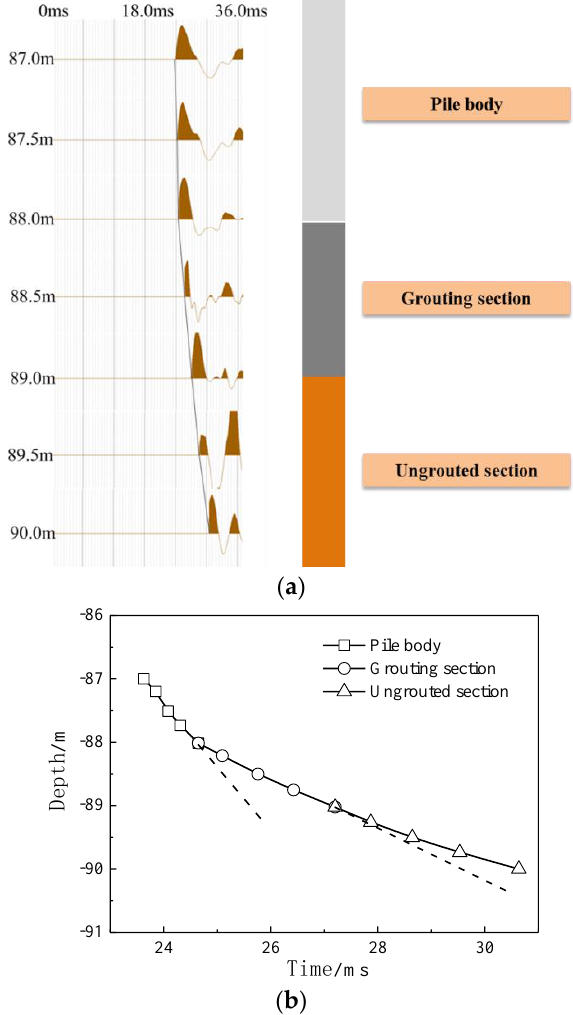
Figure 9. Test result of transmission wave in the No. 2 pile: ( a ) original data; ( b ) processed Data.